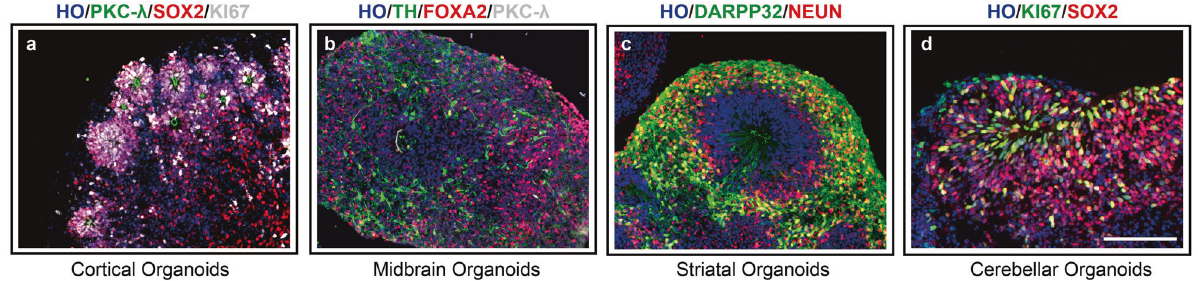
Fig. 4 “ Mini-brains ” generated from PSCs. “ Mini-brains ” representative of different brain region identities were generated in Yan Liu ’ s laboratory. a Immuno fl uorescence image of cortical organoids grown from pluripotent stem cells (PSCs) with multiple rosette-like structures. Shown are immunohistochemical staining images for the adherens junction marker PKC λ (green), the progenitor marker SOX2 (red) and the proliferative marker KI67 (green) after 30 days of differentiation. b Immuno fl uorescence of the midbrain dopamine (DA) neuron marker TH (green), the fl oor plate progenitor marker FOXA2 (red) and PKC λ (green) at 50 days in midbrain organoids. c Image of striatal organoids stained for the medium spiny neuron (MSN) marker DARPP32 (green) and the mature neuron marker NEUN (green). d Staining for KI67 (green) and SOX2 (red) in cerebellar organoids at 30 days. Scale bar, 100 μ m